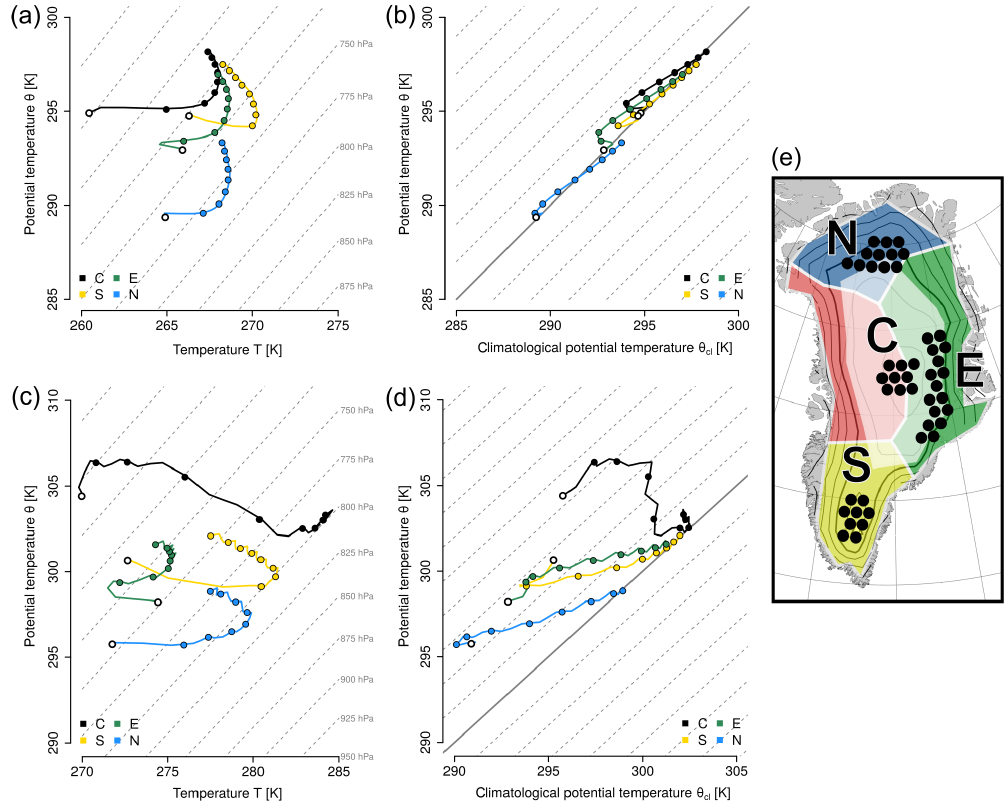
Figure 12. Thermodynamic evolution of backward trajectories from selected starting points (see e ) representative of regions C, E, S, and N. Shown are medians for each trajectory category, summarized as one air parcel, in (a, c) θ − T and (b, d) θ − θ cl space. Grey dashed lines indicate isobars in intervals of 25hPa (a, c) and isolines of constant potential temperature anomaly in intervals of 2K (b, d) . Panels (a) and (b) represent all climatological summertime air masses, and panels (c) and (d) represent melt air masses only. Circles along the lines indicate time in 24h intervals, with an empty circle at the trajectory end point at t = 0h. Note that the axis limits of (a) – (d) are not